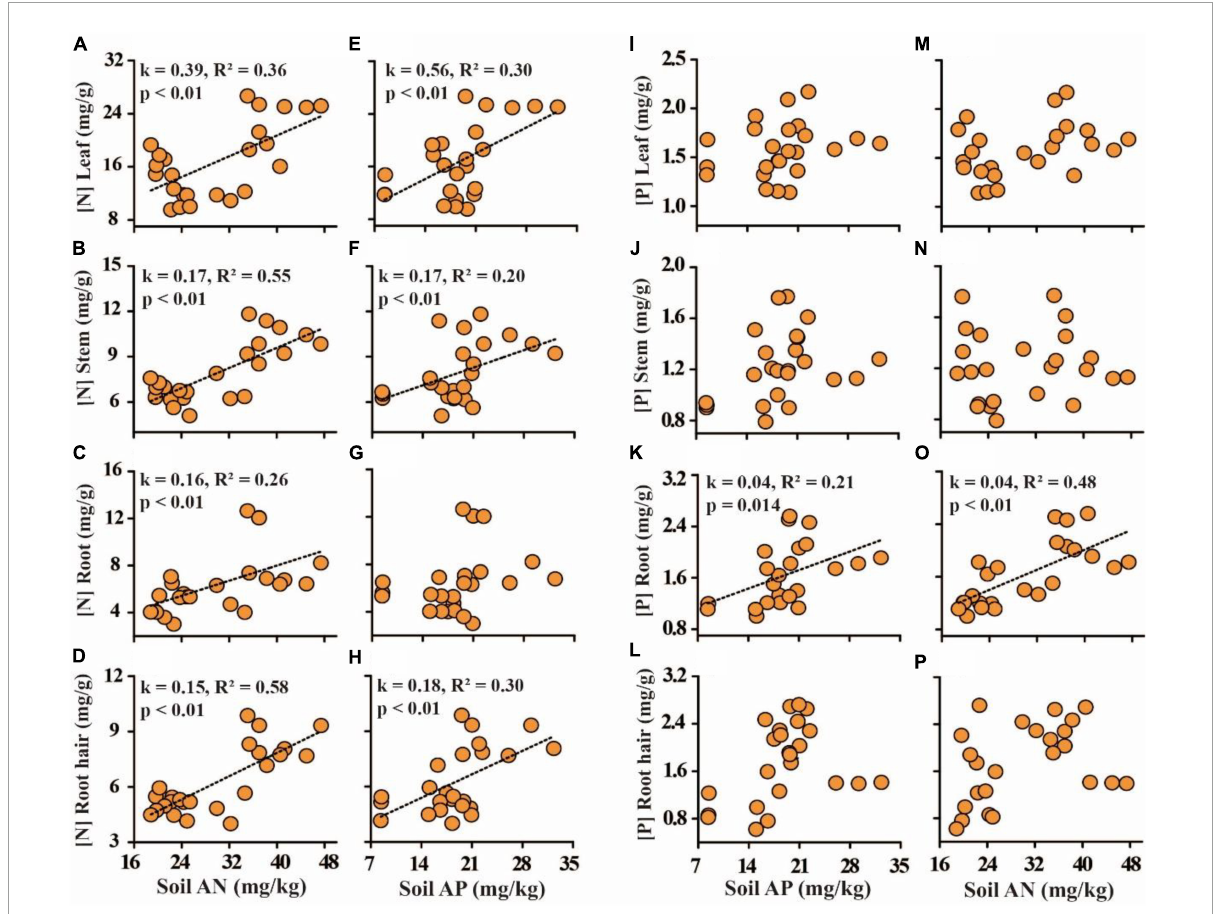
FIGURE4 The relationship between soil nutrient availability on the N and P of plant tissues. (A–D) Soil available nitrogen (AN) and plant tissue N; (E–H) soil available phosphorus (AP) and plant tissue P; (I–L) soil AP and plant tissue P; (M–P) soil AN and plant tissue